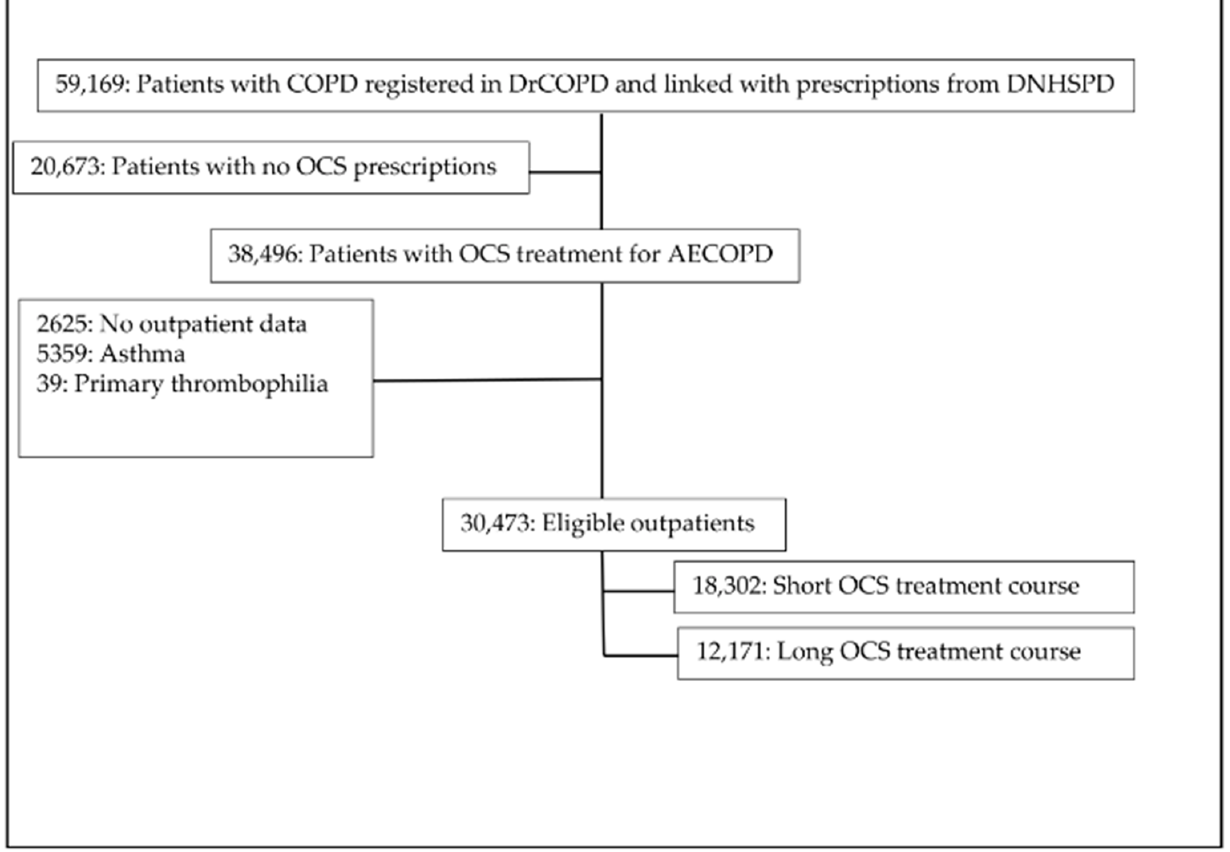
Figure 1. Study flowchart. COPD, chronic obstructive pulmonary disease; AECOPD, acute exacerbations of chronic obstructive pulmonary disease; DNHSPD, Danish National Health Service Prescription Database; DrCOPD, Danish Register of Chronic Obstructive Pulmonary Disease; OCS, oral corticosteroids.